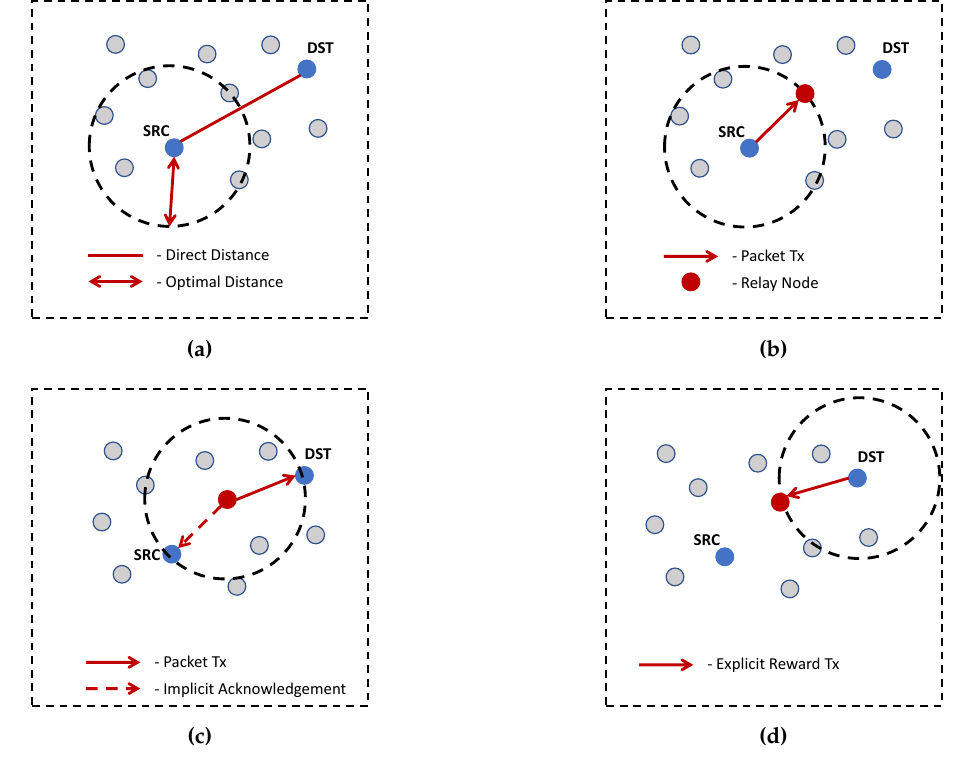
Figure 3. Example of the protocol’s